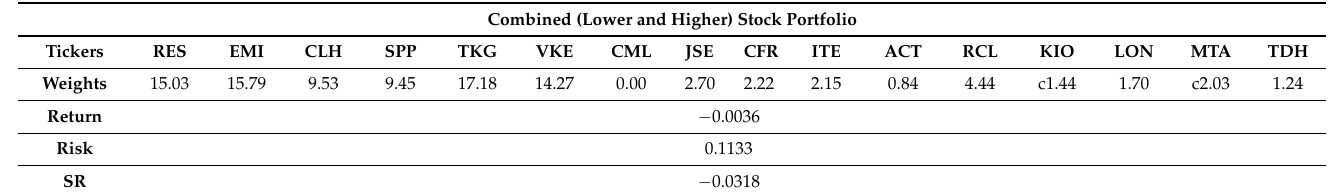
Table 6. Optimization results of the portfolio consisting of a combination of JSE stocks with lower and higher behavioral scores using the BMV approach.